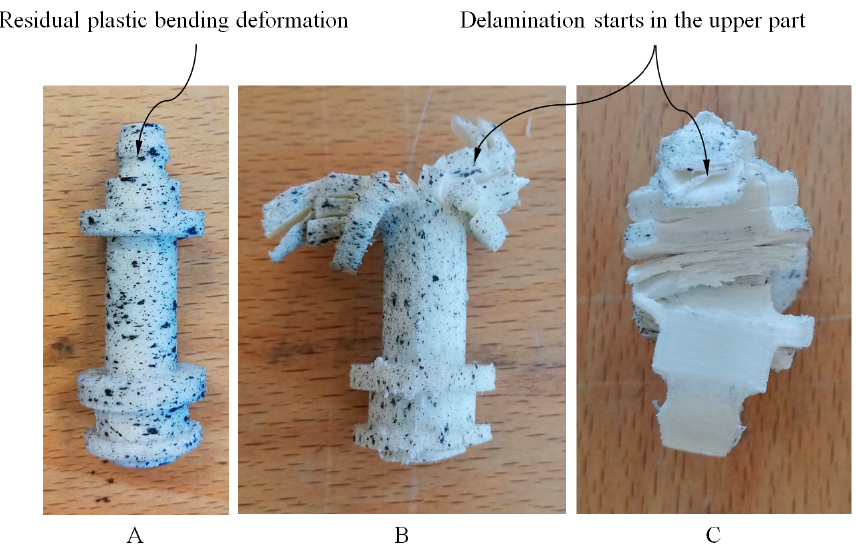
Figure 14. Fracture of the printed part under study: ( A ) Z-Axis; ( B ) X-Axis, front view; ( C ) X-Axis, top view.